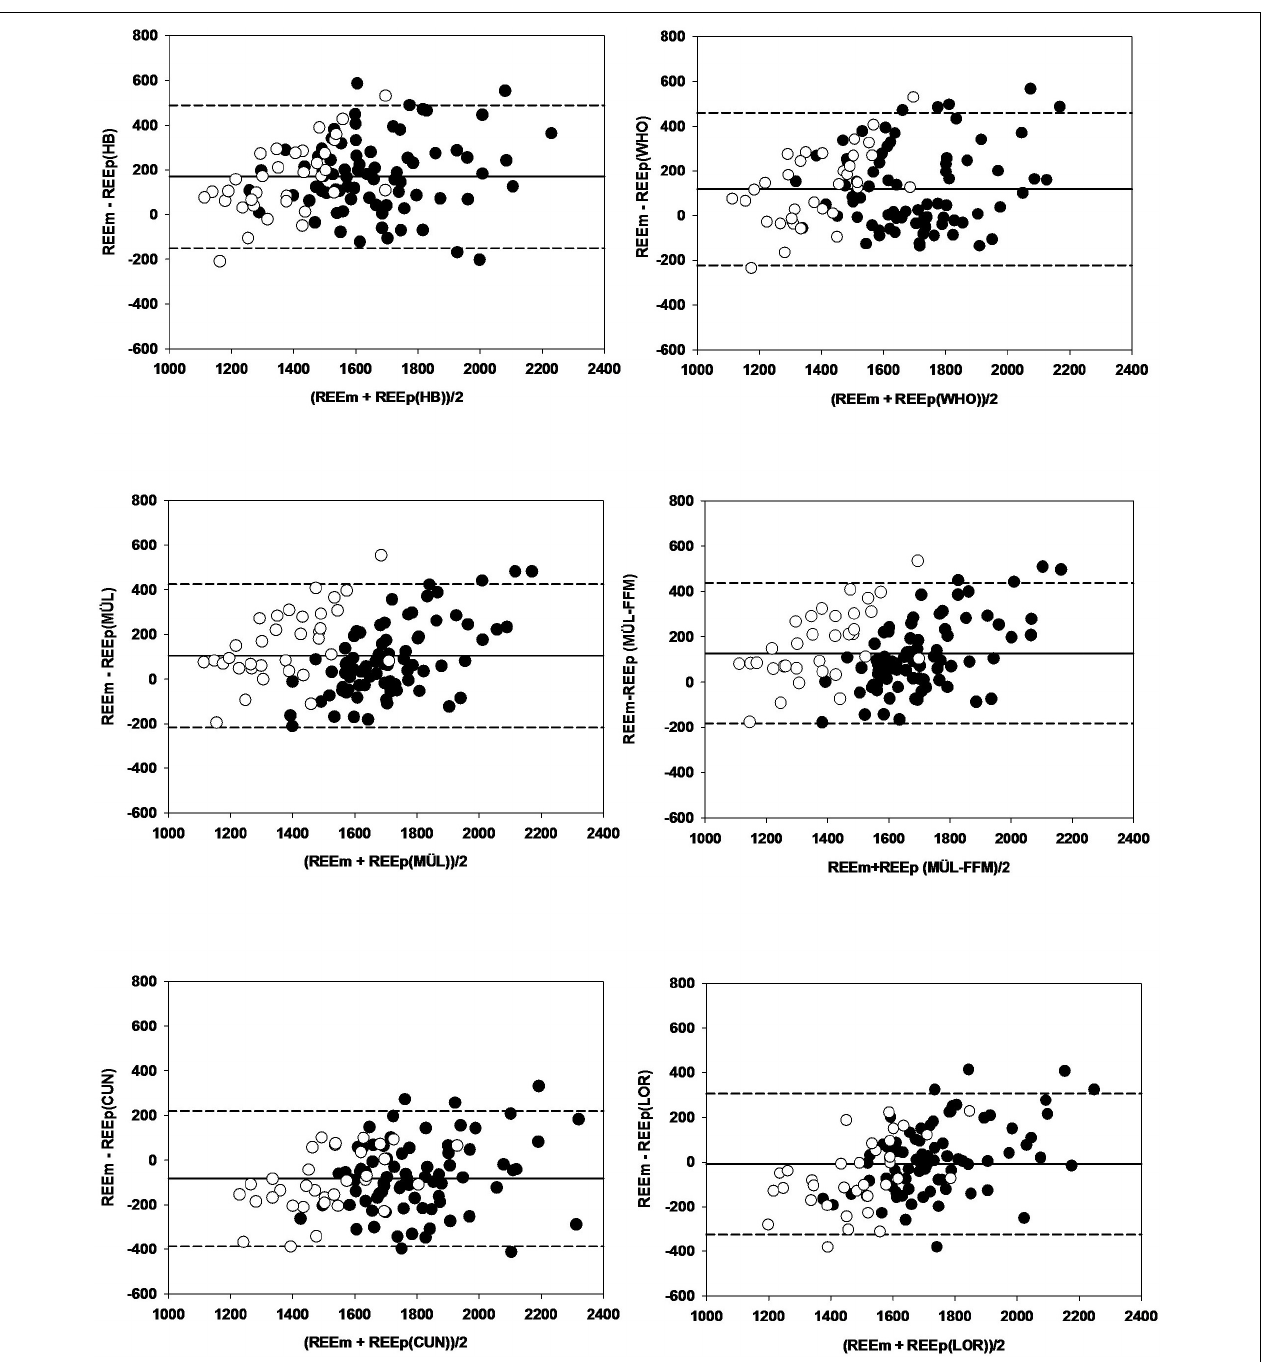
FIGURE 3 | Bland-Altman plots for six [Harris & Benedict (HB), WHO (WHO), Müller (MÜL), MÜL -FFM (MÜL-FFM) Cunningham (CUN), De Lorenzo (LOR)] resting energy expenditure (REE) predictive equations (REEp). The solid lines represent the mean difference (BIAS) between predicted and measured REE (REEm). The upper and lower dashed lines represent 95% limits of agreement. ◦ female •